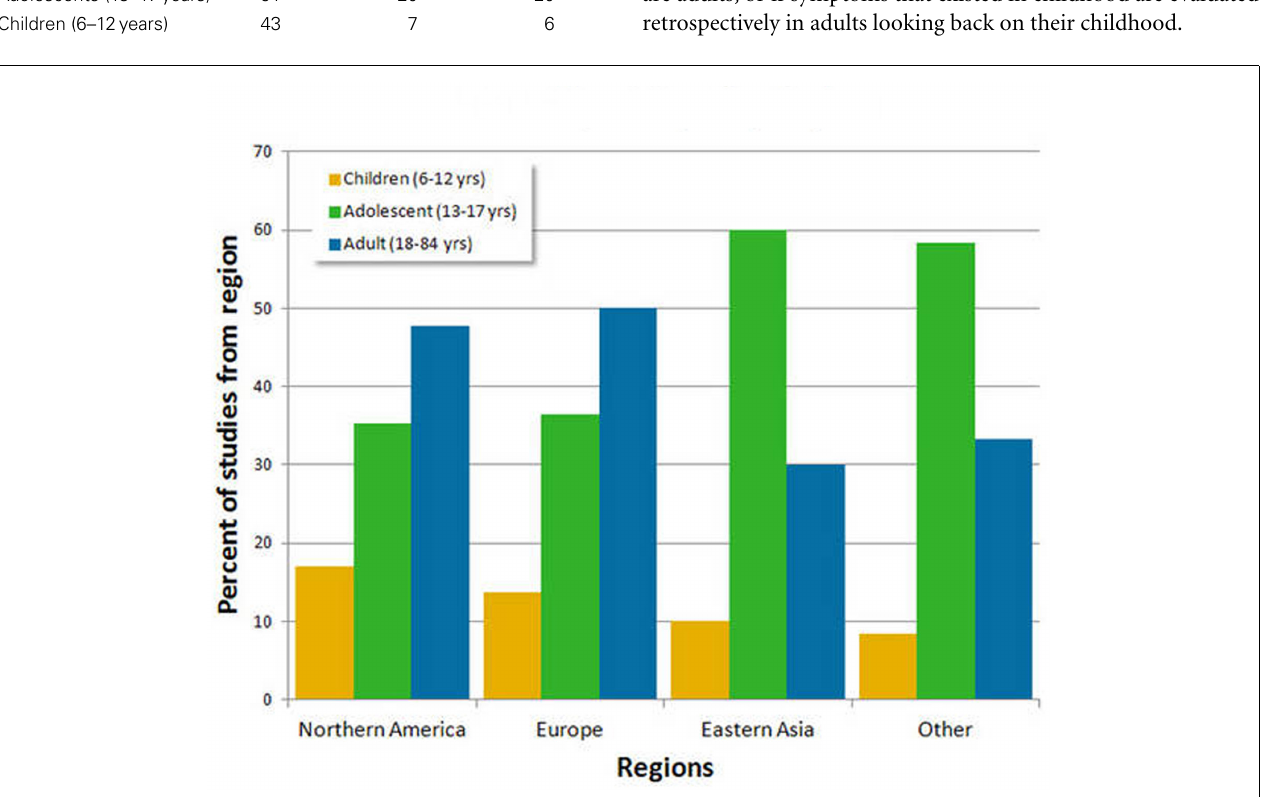
FIGURE 5 | Participant ages by region. The proportion of studies of different age groups is similar between Northern America and Europe, but studies